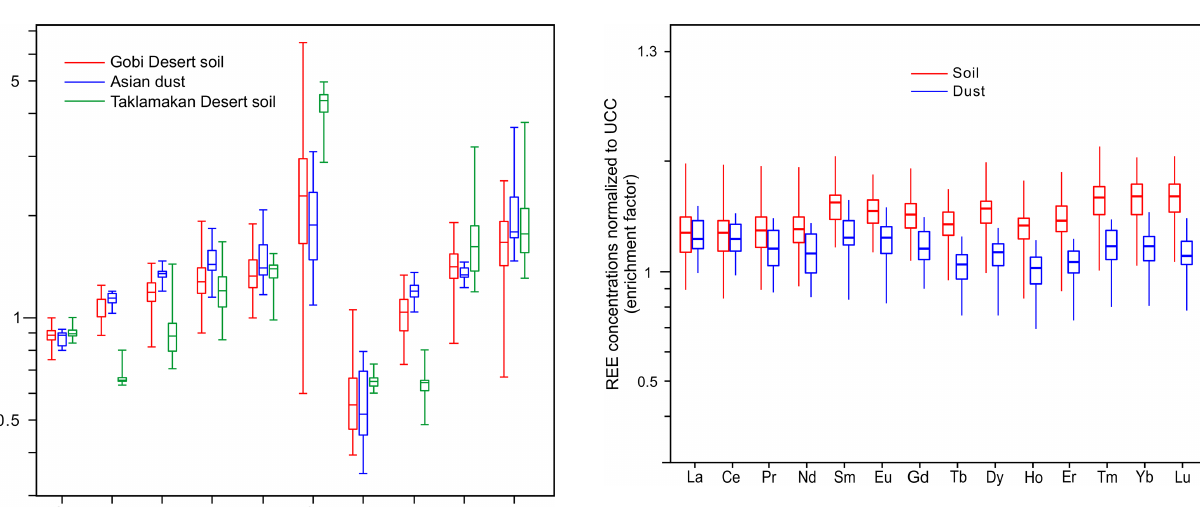
Figure 8. Box and whiskers plot comparing the rare earth element (REE) compositions between Asian dust and source soil samples, normalized to the average values of the UCC.